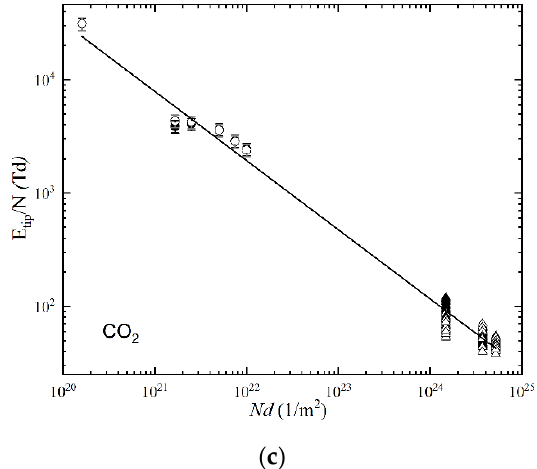
Figure 10. ( a ) E tip / N as a function of Nd in air. Experimental data, present work: ○ —negative polarity; ● — positive polarity; experimental data, literature: △ —negative polarity (monocone) [24]; ▲ — pos- itive polarity (monocone) [24]; — [23]; solid line, fitting curve, Equation (6). ( b ) E tip / N as a function of Nd in N 2 . Experimental data, present work: ○ —negative polarity; ● — positive polarity; experi- mental data, literature: △ —negative polarity (point-plane) [24]; ▲ — positive polarity (point-plane) [24]; ■ — [10]; — [35]; solid line, fitting curve Equation (6). ( c ) E tip / N as a function of Nd in CO 2 . Experimental data, present work: ○ —negative polarity; ● —positive polarity; experimental data [11]: △ — negative polarity; ▲ — positive polarity; solid line, fitting curve Equation (6).